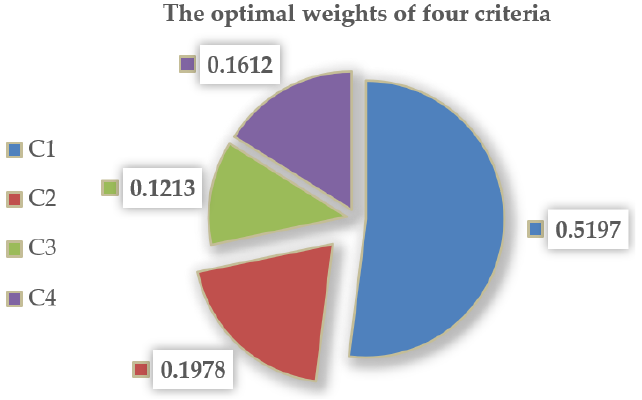
Figure 4. The optimal weights of four risk criteria.